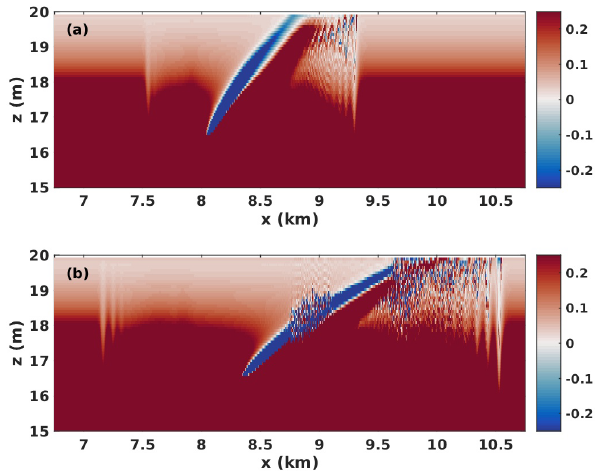
Figure 5. Case NO DJL 1. Ri at (a) 3600s and (b) t = 7200s. Colour range saturated over − 0 . 25 < Ri < 0 . 25.